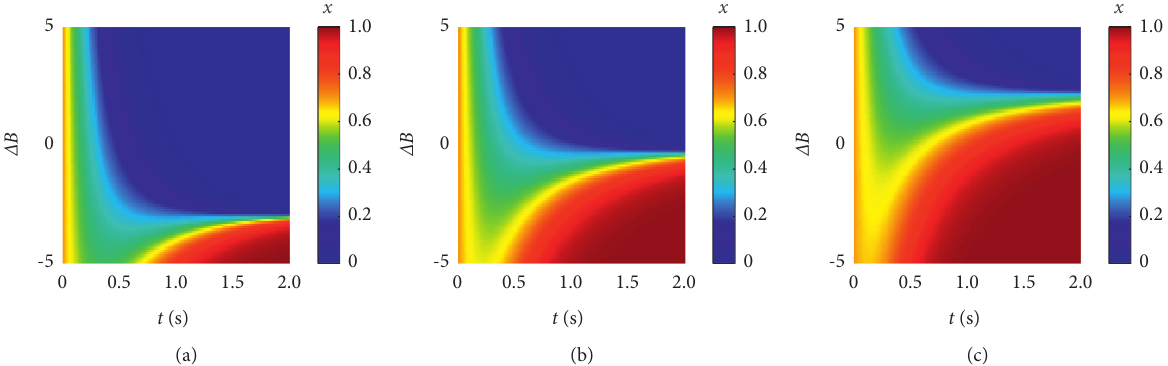
Figure 8: Evolutionary convergence of the proportion of lane changing strategy under different Δ B values. (a) α � 0; (b) α � 0 . 5; (c) α �